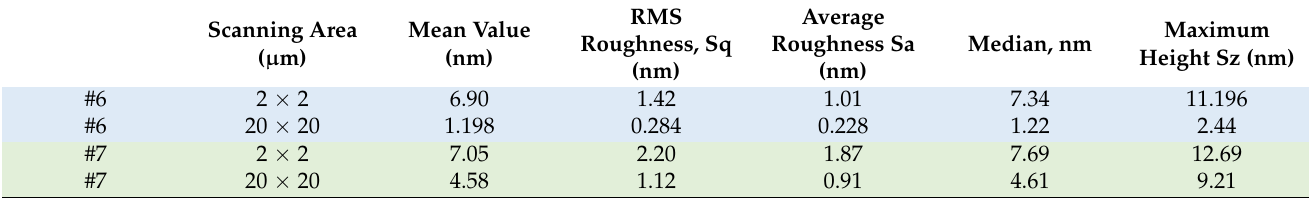
Table 3. Surface statistics parameters (over the entire scanning area).